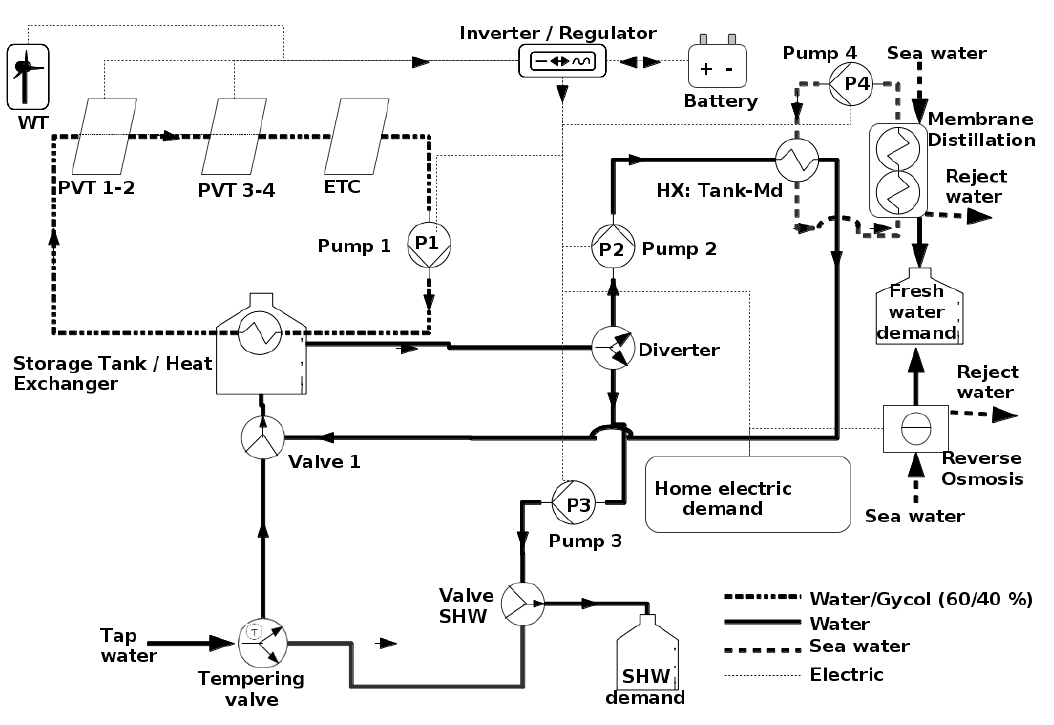
Figure 1. General description of the hybrid trigeneration system.